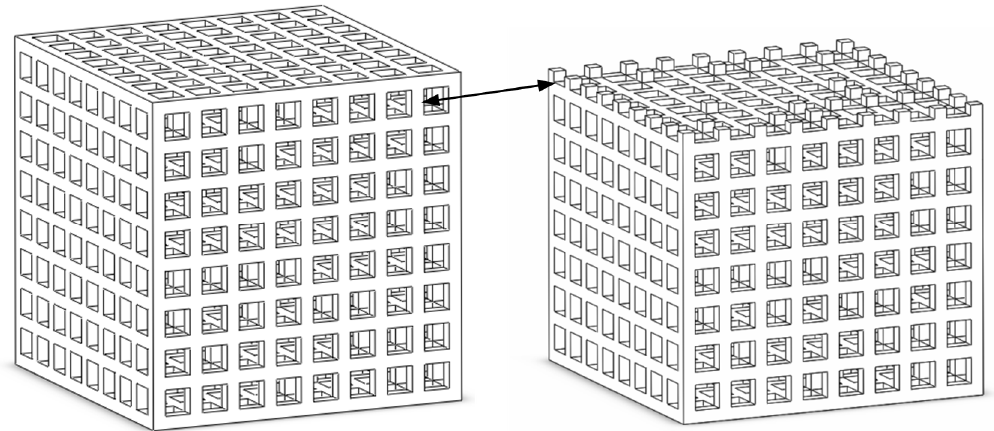
Figure 4. The honeycomb structure of the modified model 3.